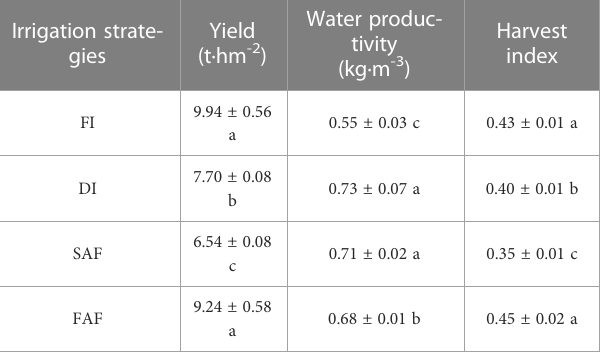
Irrigation strate-